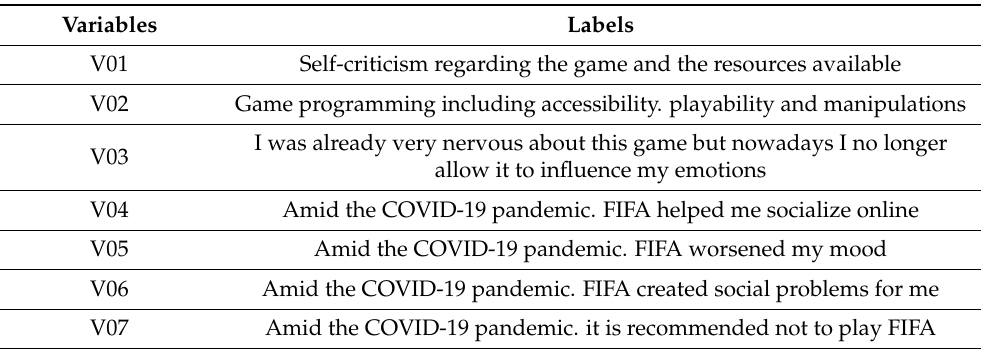
Table 8. Variable labels according to questions Q11 to Q17.